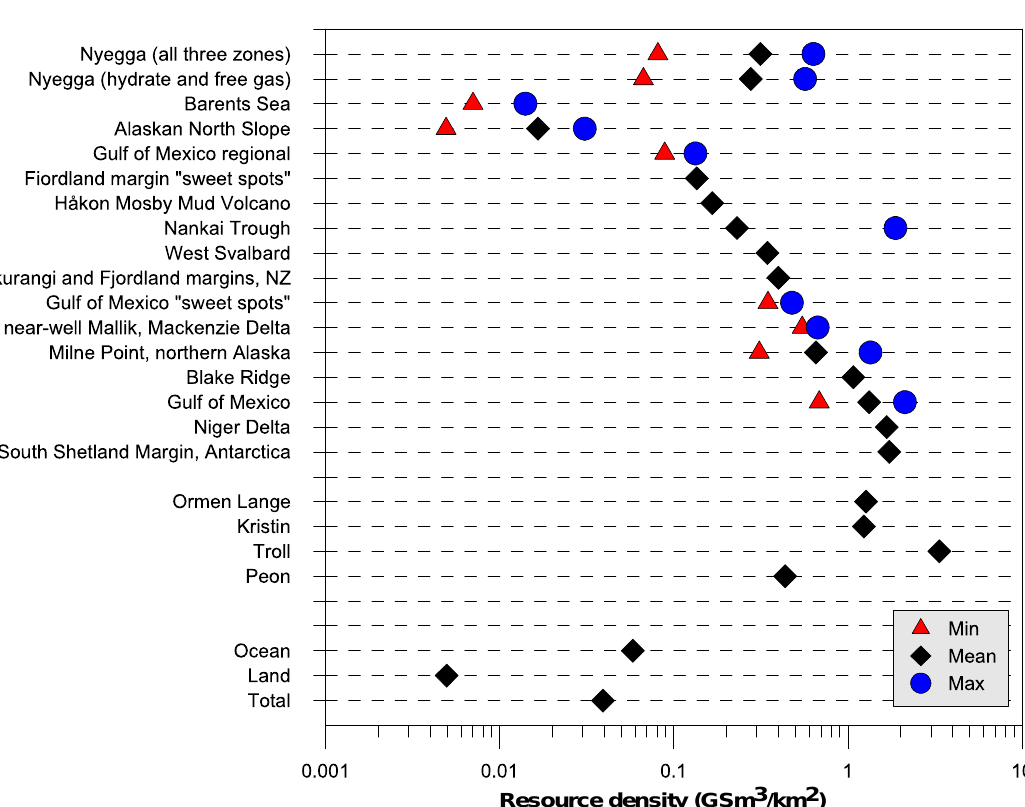
Figure 12. Graphical comparison of the resource density at the Nyegga prospect and other hydrate and conventional deposits worldwide. The diamonds indicate the average resource density, while the minimum and maximum resource densities are represented by triangles and circles, respectively. Data source identical to Table 4. Please note the logarithmic